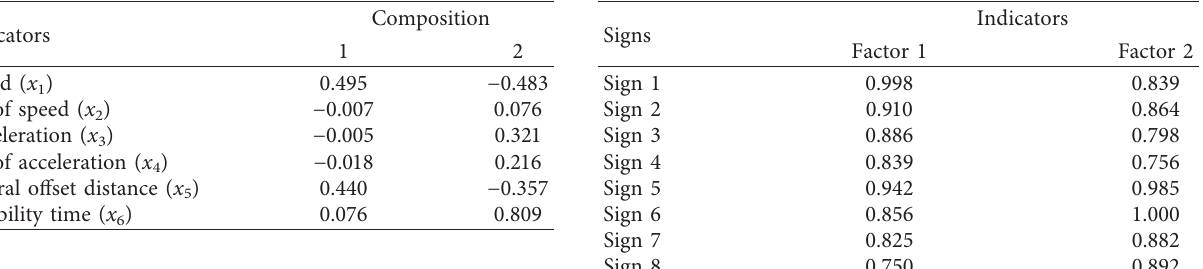
Table 11: Correlation coefficient matrix c .